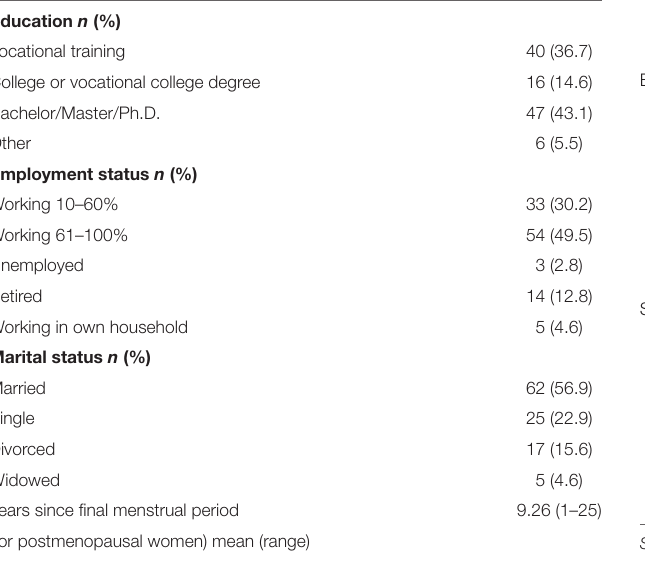
TABLE 1 | Demographic characteristics.